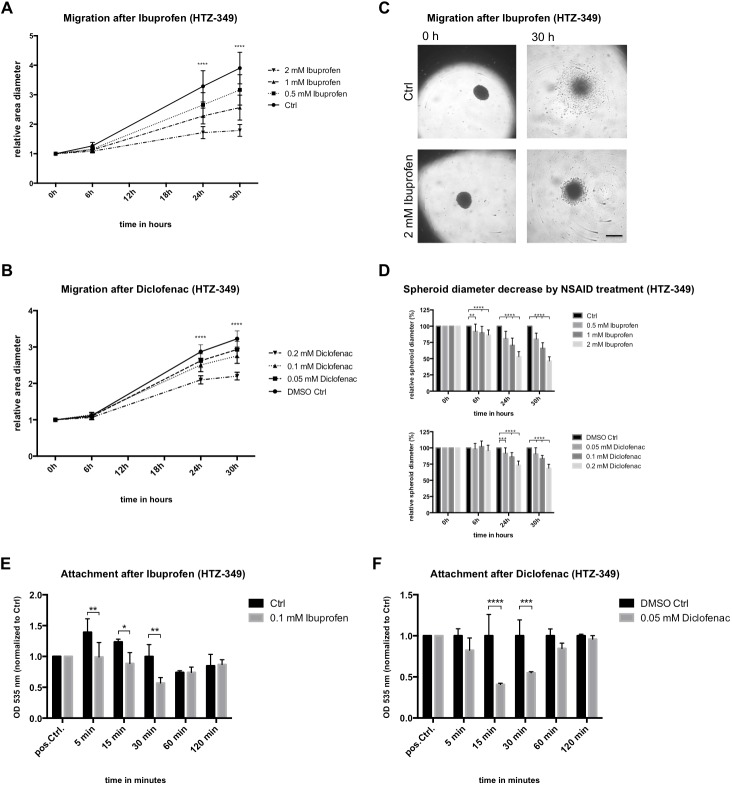
Ibuprofen and diclofenac decrease migration.Spheroids of human glioma cell line HTZ-349 (5 x 103 cells/well) were cultured in presence of increasing (A) ibuprofen (0.5–2 mM) or (B) diclofenac concentrations (0.05–0.2mM) and monitored for 30 h. During this time, pictures of cells migrating from the spheroids were taken periodically to monitor migratory capacity at treatment conditions (C) (scale bar = 500 μm). Migration was significantly inhibited by ibuprofen (A) in a time- and concentration-dependent manner. After 24 h, all concentrations demonstrated significantly greater migration over controls (95% CI, **** = p < 0.0001). (D) A high concentration of ibuprofen, 2 mM, resulted in significant migration inhibition noticeable by 6 h (S3A Fig). Diclofenac resulted in similar (B), although less pronounced (D), effects. Measurement of attachment capacities after 0.1 mM ibuprofen (E) or 0.05 mM diclofenac (F) revealed adhesion deficits of HTZ-349 cells compared to controls within the first 30 minutes (95% CI, * = 0.05 > p ≤ 0.01, ** = 0.01 > p ≤ 0.001, *** = 0.001 > p ≤ 0.0001, **** = p < 0.0001.).